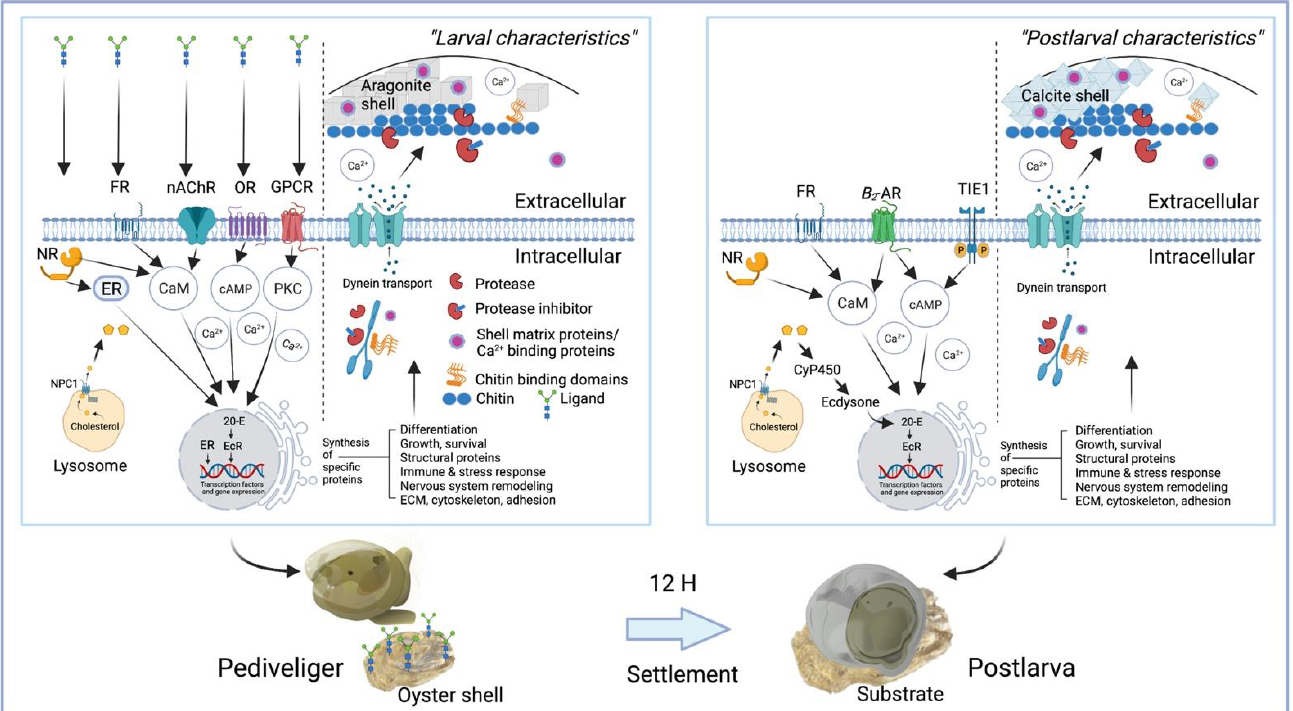
Figure 4. Schematic of the neuroendocrine-biomineralization crosstalk in C. gigas conspecific cue-induced larval settlement. This indicates the biological and molecular processes identified through the differential transcript expression in the competent pediveliger as it transitioned into postlarvae by conspecific cue-mediated settlement induction. As the pediveliger commences its searching behavior, it makes use of its external chemoreceptors to detect signals for a suitable location for settlement. Once it detects a ligand and other signaling cues coming from shells of conspecifics, various intracellular signaling receptors act in a concerted way and a molecular switch is turned on for the initiation of downstream signal cascades into the nucleus with the possible involvement of the ecdysone signaling pathway. Then, various transcription factors and gene expressions for the synthesis of specific proteins are activated. Subsequently, rapid morphological, physiological, structural, and functional changes occur as the competent pediveliger undergoes its metamorphosis into a postlarva within 24 h. Abbreviations: NR, nuclear receptor; FR, FRMF (Phe-Met-Arg-Phe) amide receptor; nAChR, neuronal acetylcholine receptor; OR, octopamine receptor; GPCR, leucine-repeat-containing GPCR 4; ER, estrogen receptor; CaM, calmodulin groups; cAMP, cAMP-regulated D2 protein; PKC, protein kinase C; Ca 2+ , calcium ion; NPC1, NPC cholesterol transporter 1; 20-E, hydroxyecdysone; EcR, ecdysone receptor; B 2 AR, β 2 adrenoreceptor; TIE 1, tyrosine-protein kinase receptor TIE; CyP450, cytochrome P450; and P, phosphate. Some concept models were adapted and modified to illustrate processes of shell formation [77], chitin-mediated biomineralization [78], and dynein transport [79] that reflect the transcriptome larval settlement dynamics in our study. This figure was created using BioRender.com.